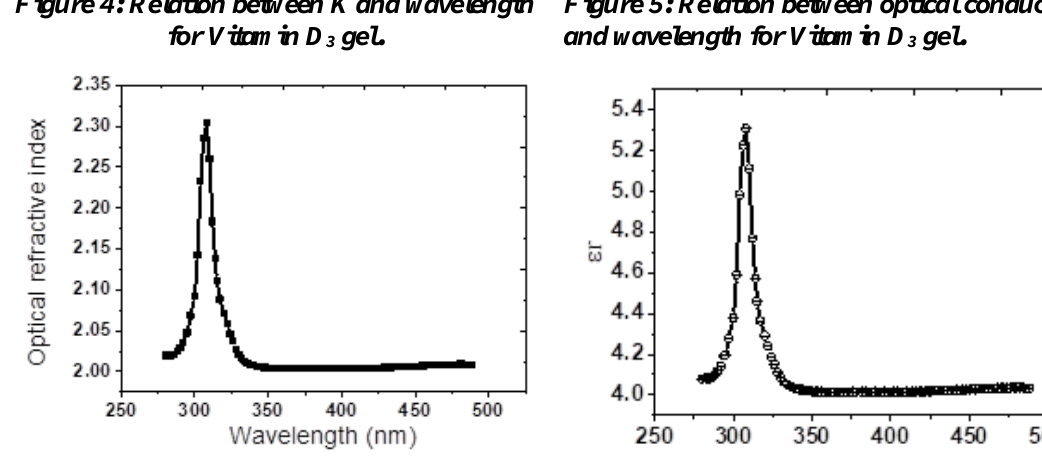
Figure7: Relationship between realdielectric constant and wavelength for Vitamin D